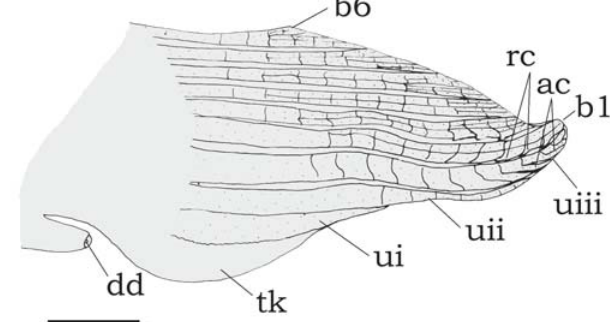
Fig. 29. Male modified anal fin of Tatia intermedia , MZUSP 44255, 65.5 mm SL. Left side lateral view. Abbreviations: ac , antrorsely curved denticulation; b1 , branched first ray; b6 , branched sixth ray; dd , deferent duct; rc , retrorsely curved denticulation; tk , tegumentary keel; ui , unbranched first ray; uii , unbranched second ray; uiii , unbranched third ray. Scale bar = 1.0